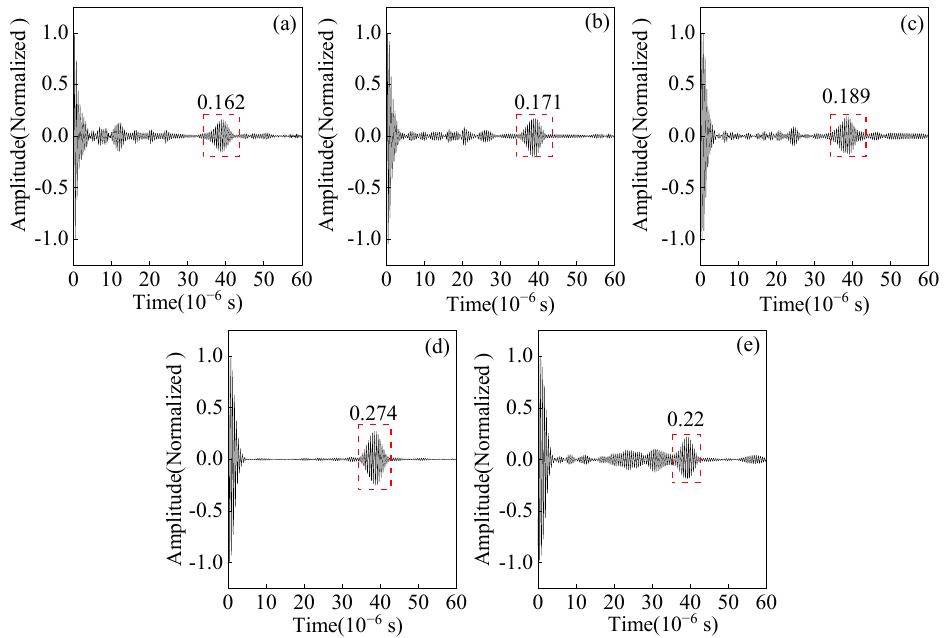
Figure 24. Effect of code element length on the main lobe amplitude of simulation signal from angled SV wave EMAT after pulse compression ( a ) T = 0.5 μ s ( b ) T = 1 μ s ( c ) T = 1.5 μ s ( d ) T = 2 μ s ( e ) T = 2.5 μ s.